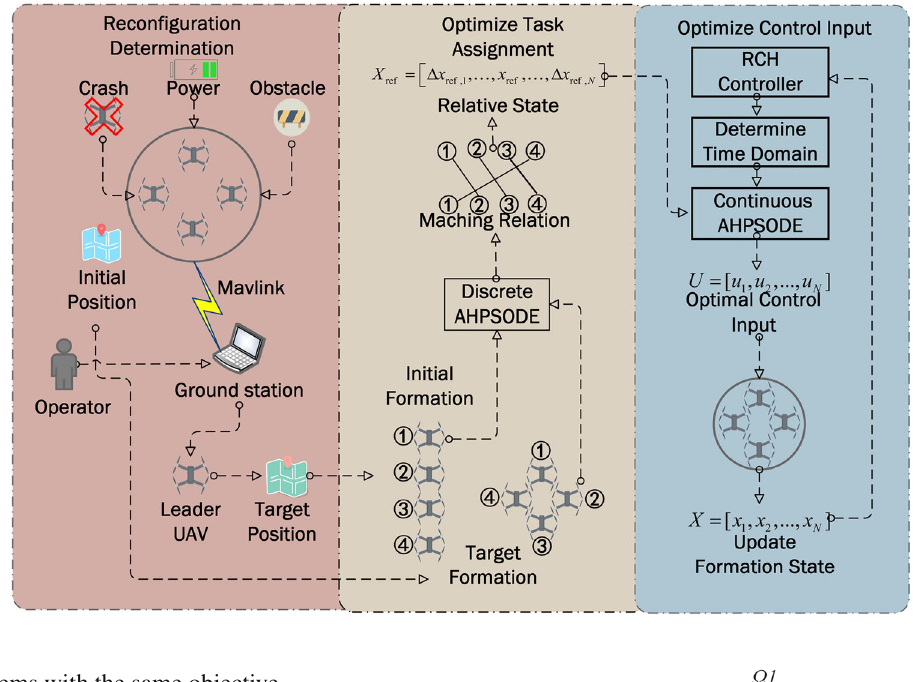
Fig. 5 Process of multi-UAV formation reconfiguration